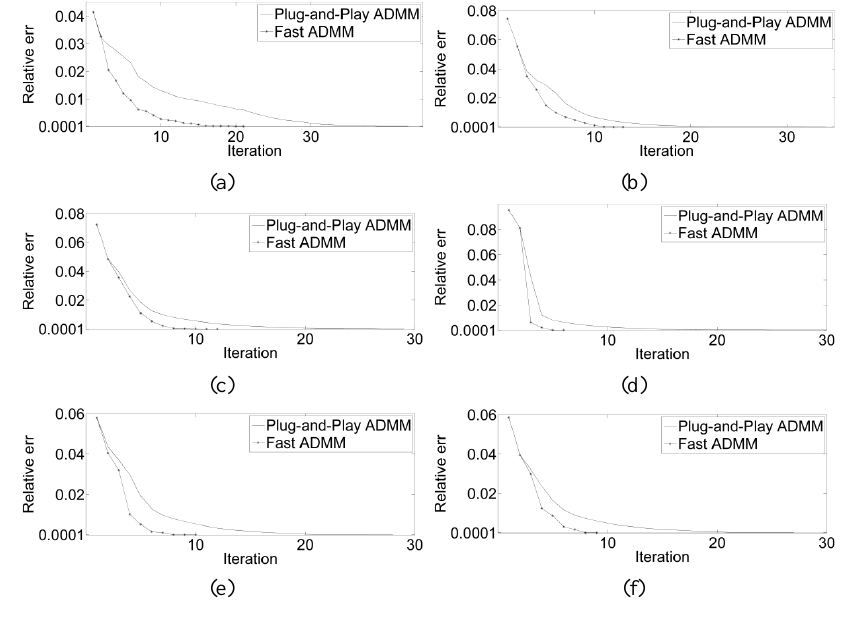
Figure 3. Comparisons of the convergence between the fast ADMM and plug-and-play ADMM. White Gaussian noise was added to the images: ( a ) birds, ( b ) streets, ( c ) crossroads, ( d ) buildings, ( e ) passerby, and ( f )